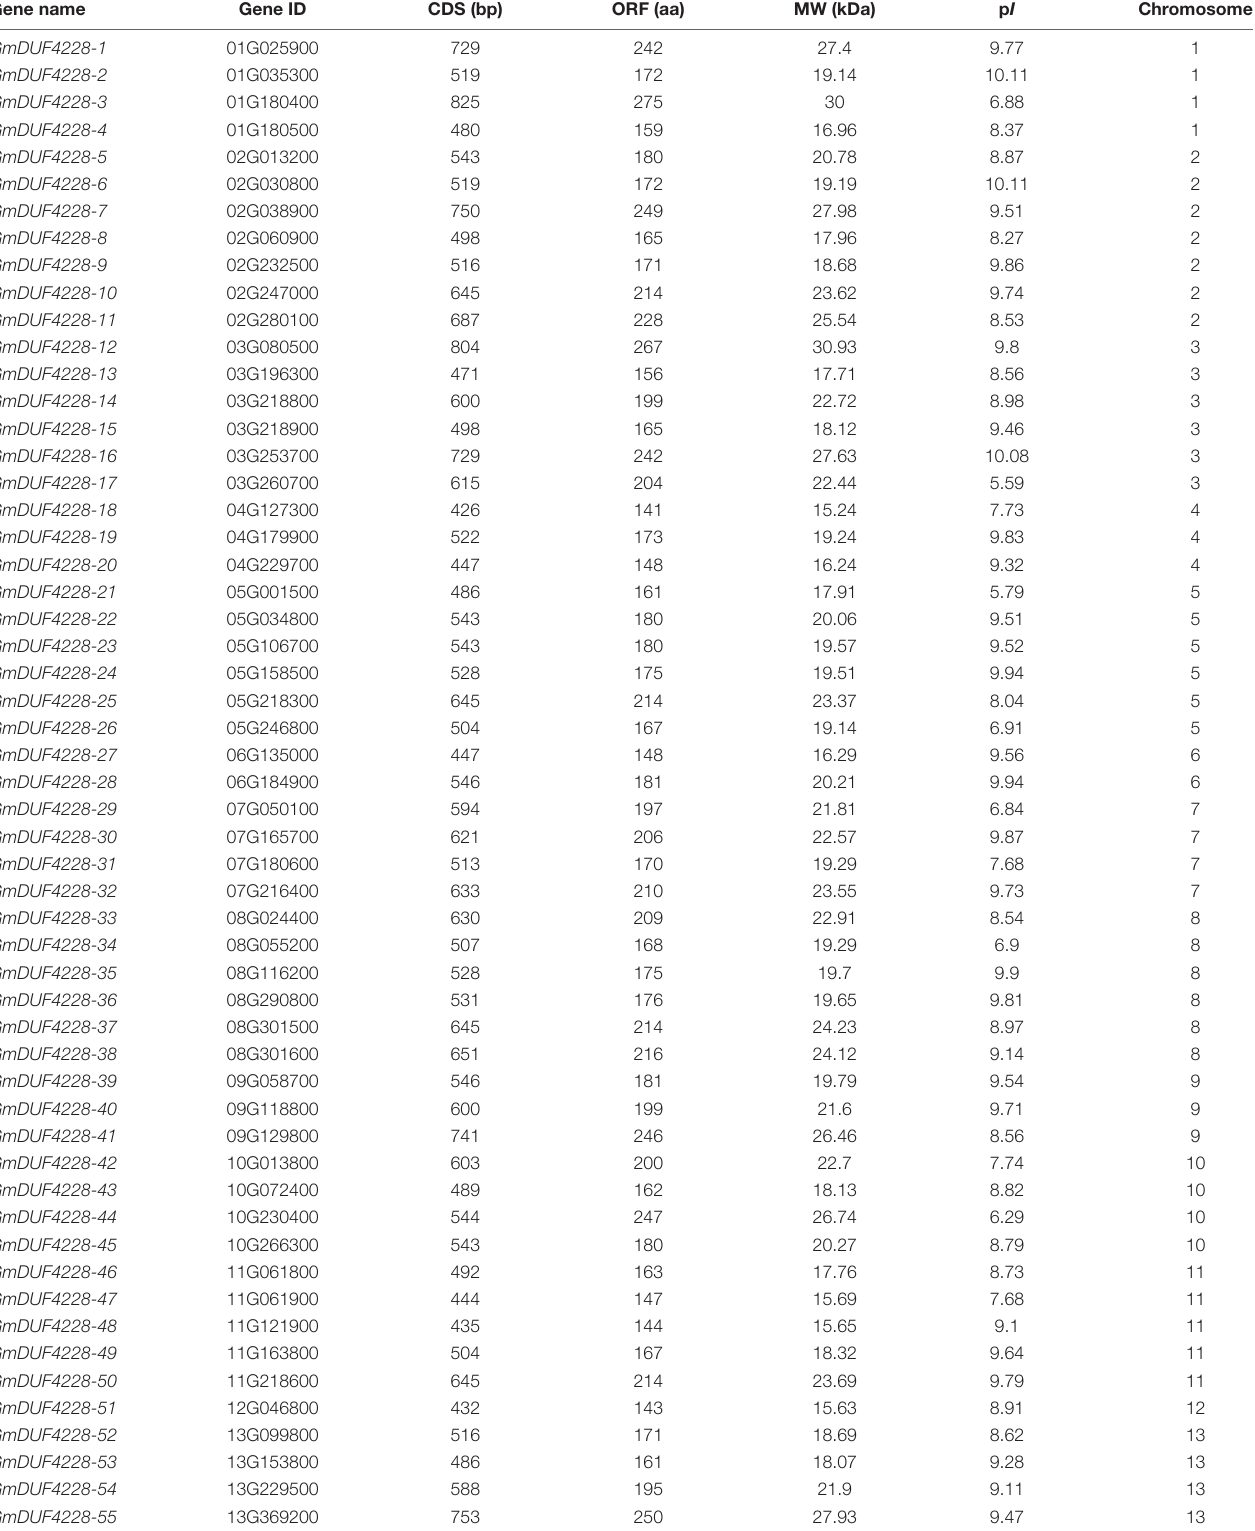
TABLE 1 | Molecular characteristics of the GmDUF4228 genes identified in